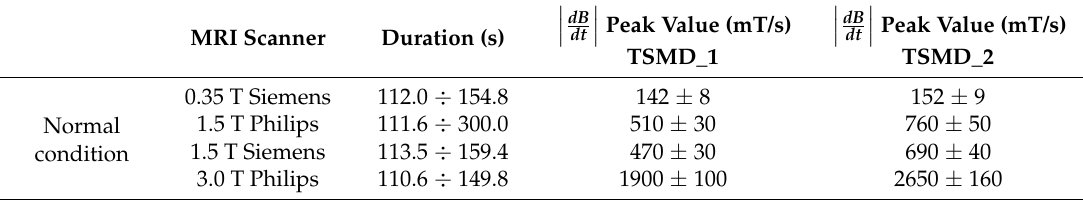
Table 1. Measurements conducted in different MRI sites using the TSMDs positioned on the MRI technicians’ Torso during routine patient positioning (Normal) simulating an emergency